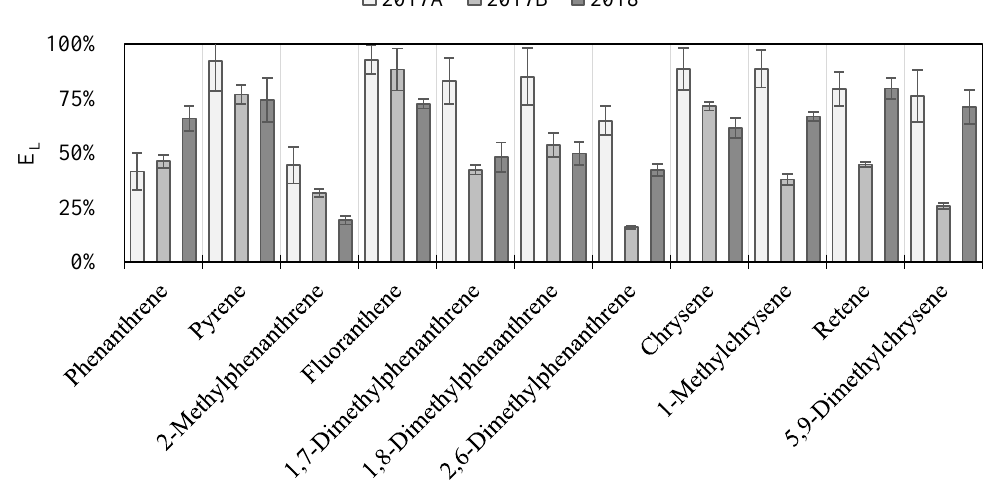
Figure 5. Mass-removal e ffi ciency of PAHs measured in all three deployments of PES in the Kearl treatment wetland.